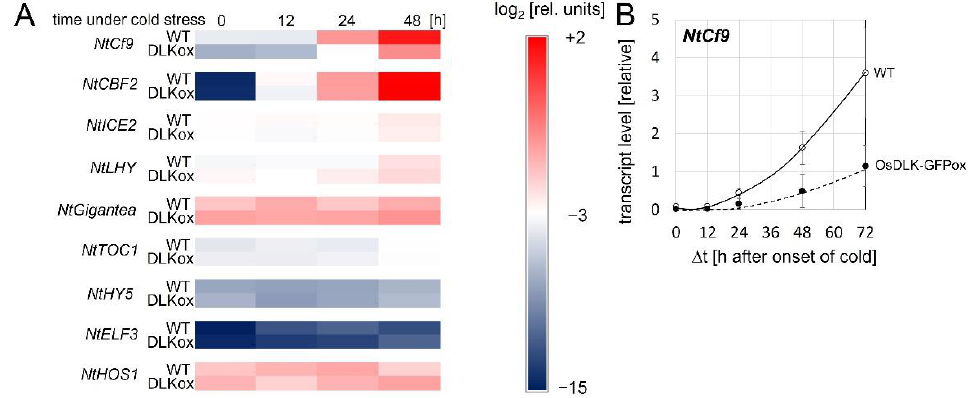
Figure 4. Time course of steady-state transcript levels under continuous cold stress (0 °C) in non- transformed tobacco BY−2 cells (WT), and in cells expressing OsDLK-GFP under control of the CaMV 35S promoter (OsDLK-GFPox). ( A ) Heat map showing transcript levels of NtCf9, the tobacco homologue of CBF4, in comparison to other genes involved in cold signalling. These are Cold Box Factor 2 (CBF2), a transcriptional activator of cold-responsive genes; Inducer of CBF expression (ICE2), the master switch for CBFs; Late Elongated Hypocotyl, a regulator of CBFs acting in parallel with ICE; Gigantea, a positive regulator of freezing tolerance acting independently of CBFs; Timing of Cab Expression 1 (TOC1), a phytochrome-dependent repressor of CBF expression; Hypocotyl 5 (HY5), a light-dependent regulator of cold acclimation acting independently of CBFs; Early Flowering 3 (ELF3), a phytochrome-dependent regulator of CBFs; and High Expression of Osmotically Responsive Genes (HOS1), a negative regulator of CBFs. ( B ) Transcript levels of NtCf9. Data represent means and standard error from five independent experimental series with three technical replications per set. All data are normalised to the same scale, based on the DC t values.